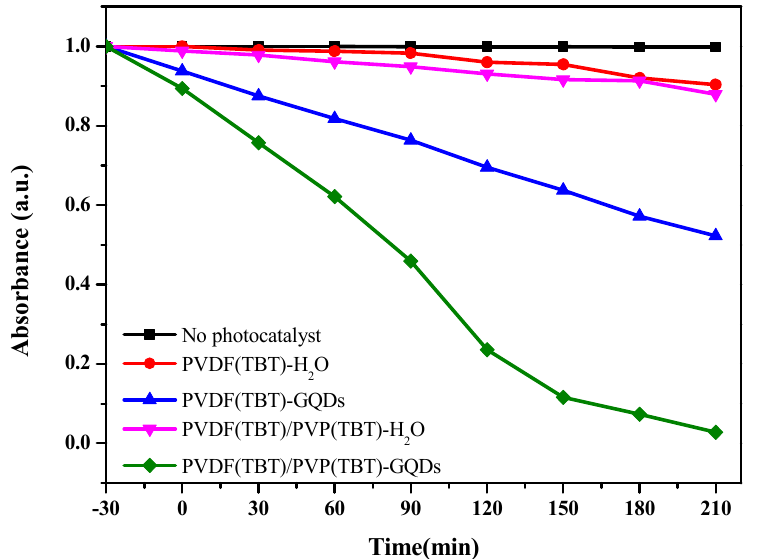
Figure 7. Degradation rate of RhB by the photocatalyst prepared without the photocatalyst, PVDF(TBT)-H 2 O, PVDF(TBT)-GQDs, PVDF(TBT)/PVP(TBT)-H 2 O, and PVDF(TBT)/PVP(TBT)-GQDs.